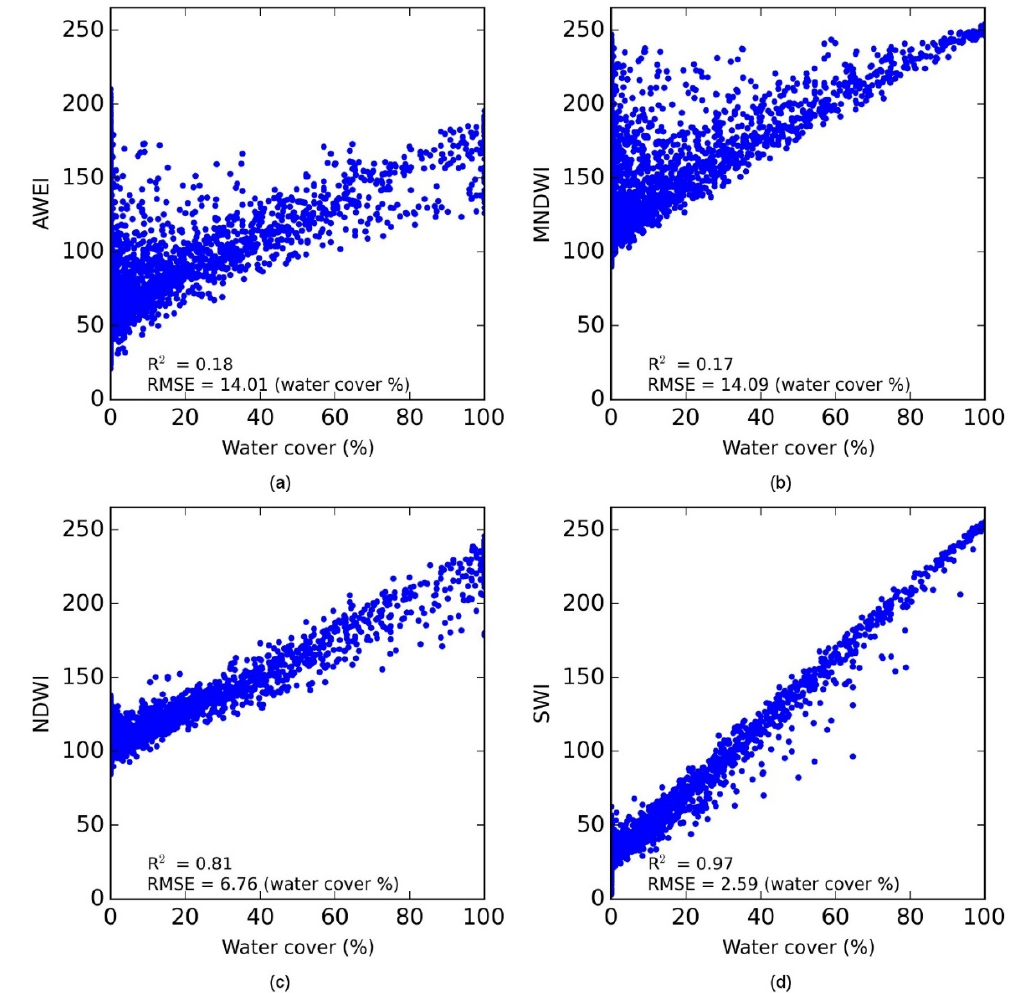
Figure 7. The sensitivity of different water indices to the water cover in a dry region: ( a ) Automated Water Extraction Index (AWEI) vs. water cover, ( b ) Modified Normalized Difference Water Index (MNDWI) vs. water cover, ( c ) Normalized Difference Water Index (NDWI) vs. water cover, ( d ) Superfine Water Index (SWI) vs. water cover. The monthly variation of the green, near infrared, saturation, and SWI over the water and